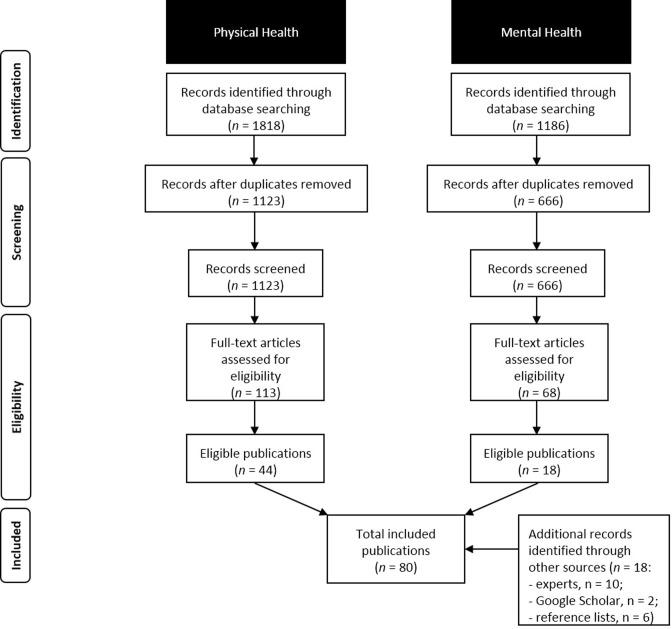
Flow diagram of study selection.